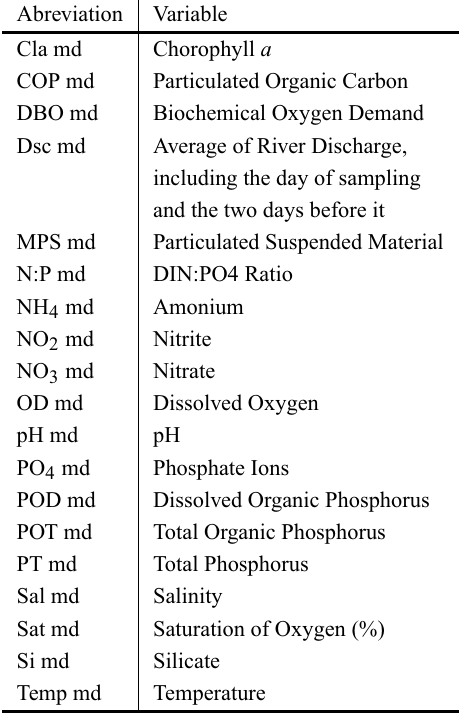
Abbreviations of the variables used in the multivariate analyses. In the spatial analysis, the overall average of each variable was used, in each station. In the temporal analysis, the overall average of each variable was used, for each sampling